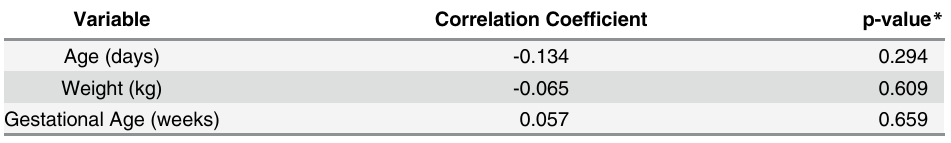
Table 1. Correlation between Head-tilt Angle of Patent Airways and Age, Weight, and Gestational Age of Newborn